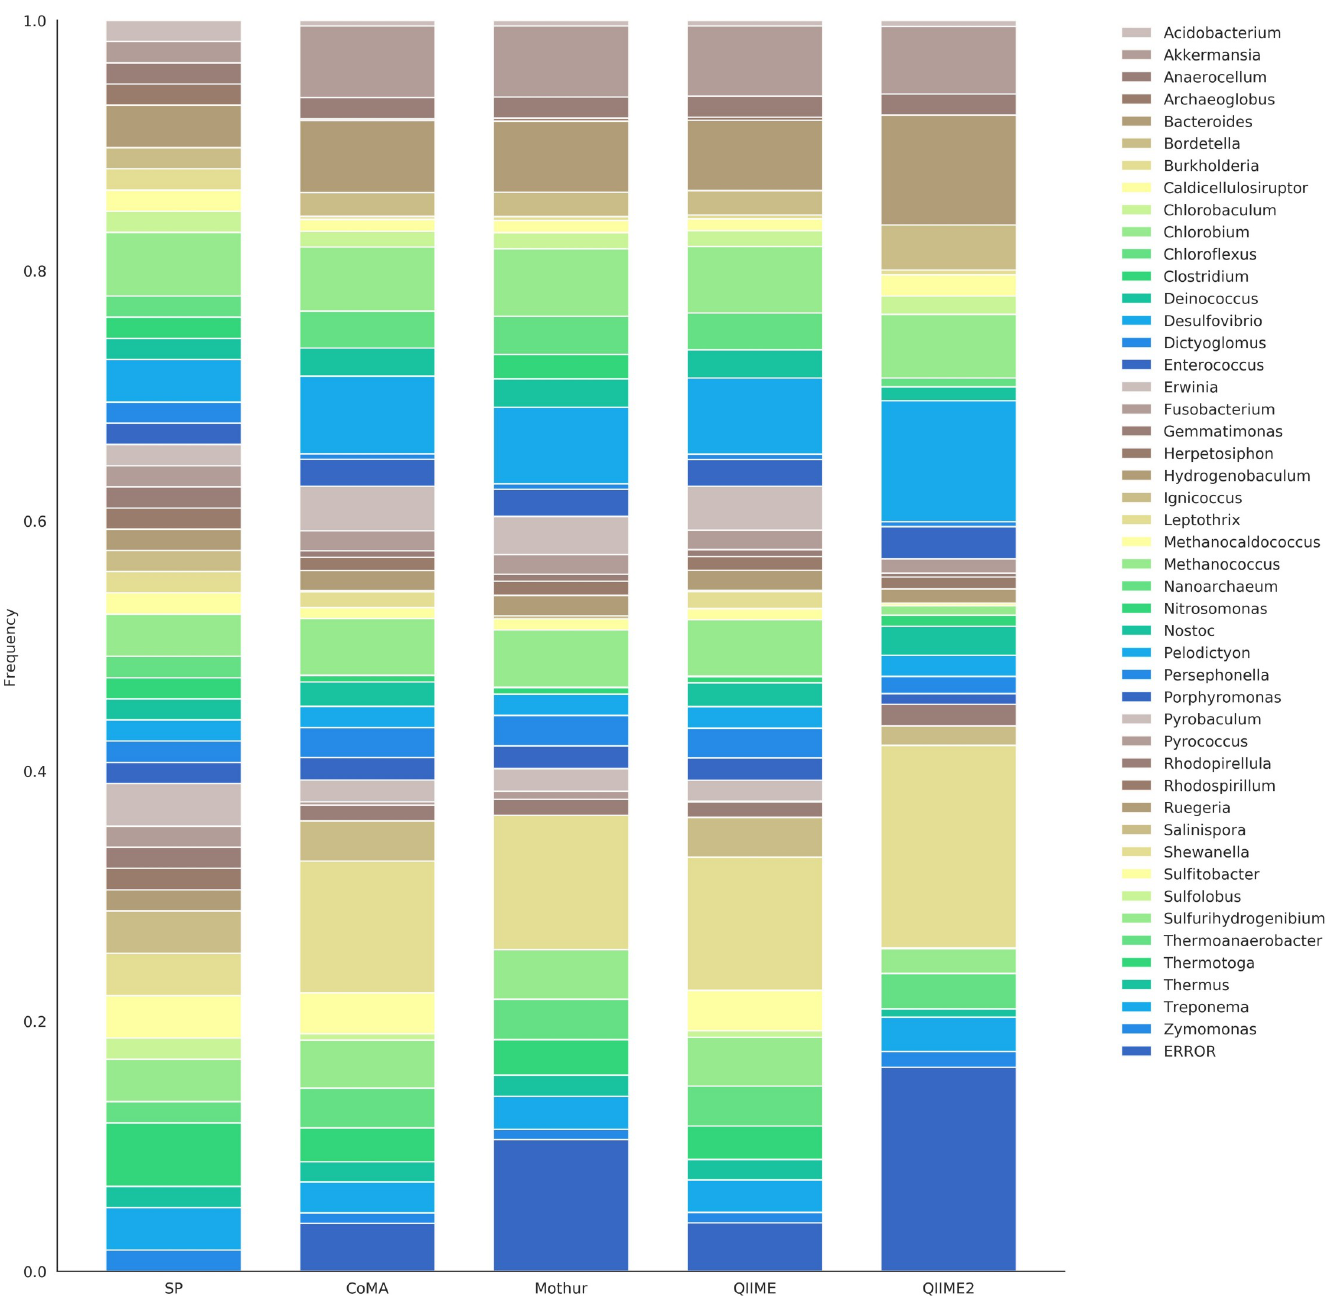
Fig 3. Community composition of the mock-16 dataset, revealed with four different analysis platforms. The set point (SP) depicts the theoretically expected distribution and serves as reference. The dataset comprised 46 archaeal and bacterial genera, targeted with 16S rRNA amplicon sequencing. https://doi.org/10.1371/journal.pone.0243241.g003 genus out of ten tested sequences (10.53% and 16.31%, respectively). Cluster analysis based on the mock-16 results revealed a cosine distance < 0.01 between CoMA and QIIME, indicating a very high similarity between these two pipelines (S3 Fig). With a cosine distance of 0.08, Mothur was closer related to them than to QIIME2. However, as seen before for mock-13 , all applied pipelines were much closer related to each other (maximum distance: 0.15) than to the set point (overall distance: 0.30).